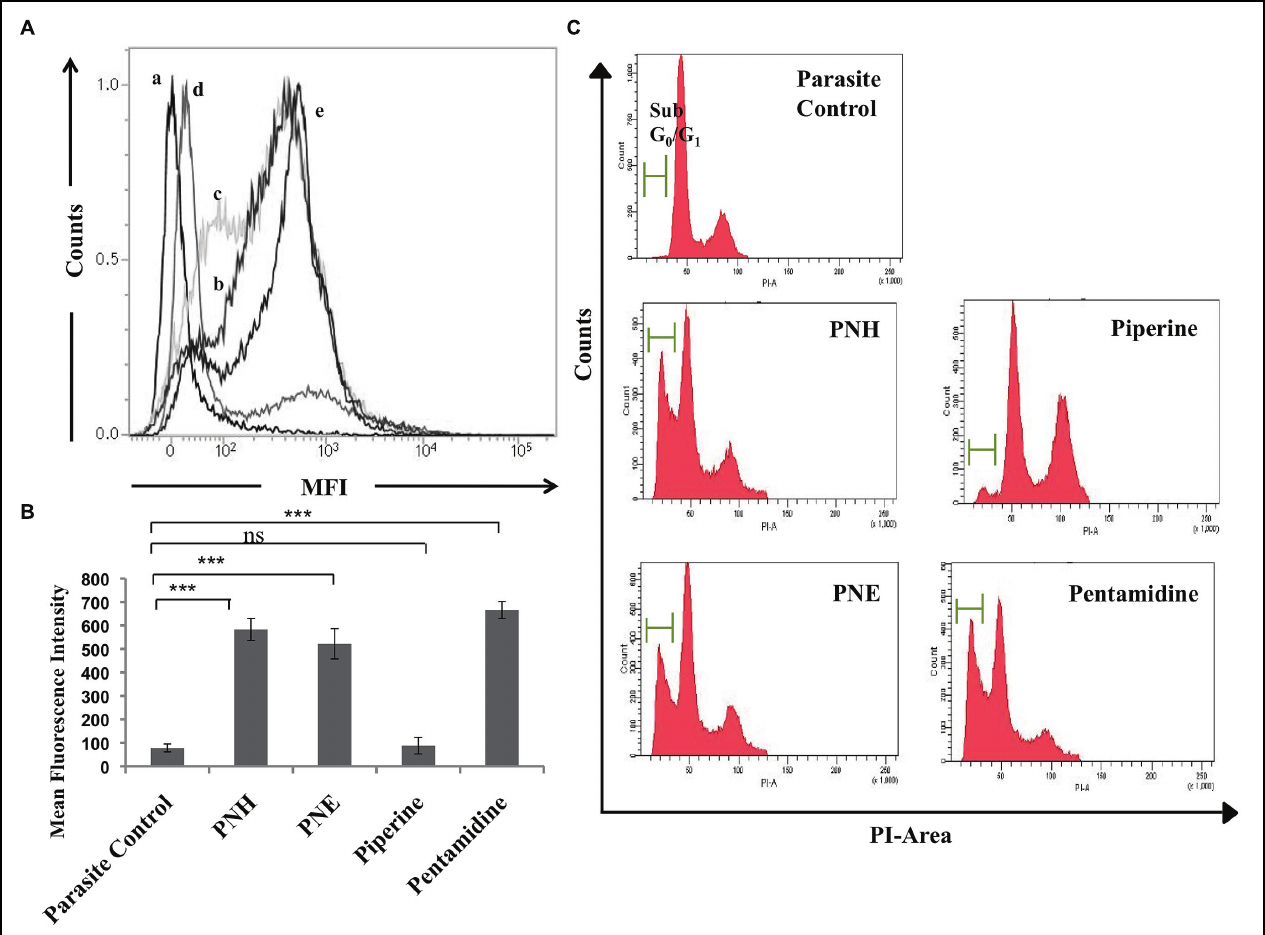
FIGURE 2 | Study of apoptotic correlates post-treatment with bioactive fractions. (A) DNA fragmentation in treated promastigotes illustrated by TUNEL assay. The promastigotes (2 × 10 6 ml − 1 ) were treated with bioactive fractions and compounds (500 μ g ml − 1 ) for 72 h at 22 ◦ C after which the cells were processed according to manufacturer’s instructions and acquired on BD LSR II flowcytometer. Histograms depict shift in MFI of (b) PNH, (c) PNE, (d) piperine, and (e) pentamidine with respect to (a) parasite control. (B) Bar graph representing the specific MFI values indicative of TUNEL positivity in PNH, PNE and pentamidine treated samples. ∗∗∗ P < 0.001 and ns = non-significant with respect to parasite control. (C) Detection of sub G 0 -G 1 or apoptotic population. Promastigotes (2 × 10 6 ml − 1 ) were untreated or treated (500 μ g ml − 1 , 72 h, 22 ◦ C) with bioactive fractions and processed for cell cycle analysis as described in